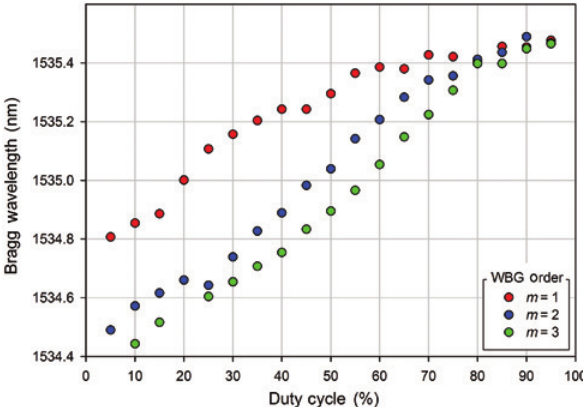
Figure 6: Bragg wavelength as a function of duty cycle for various WBG orders m . WBGs were fabricated in a 4-mm-long silicate glass sample using the modulated burst method.